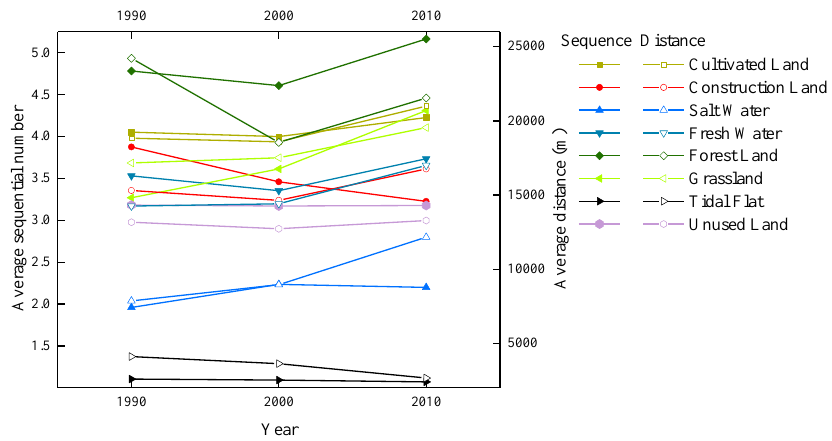
Figure 10. The comparison of the distance (average distance from land use to the shoreline) and a sequential number of land use along the sea – land direction from 1990 to 2010. Table 4. Land use transformation matrix, 1990 – 2000 (in km).